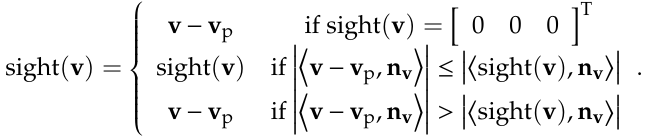
( b ) Figure 6. Corrupted thin surface vs. the correct thin surface; ( a ) interfered TSDF and corrupted surfaces; ( b ) correct TSDF.